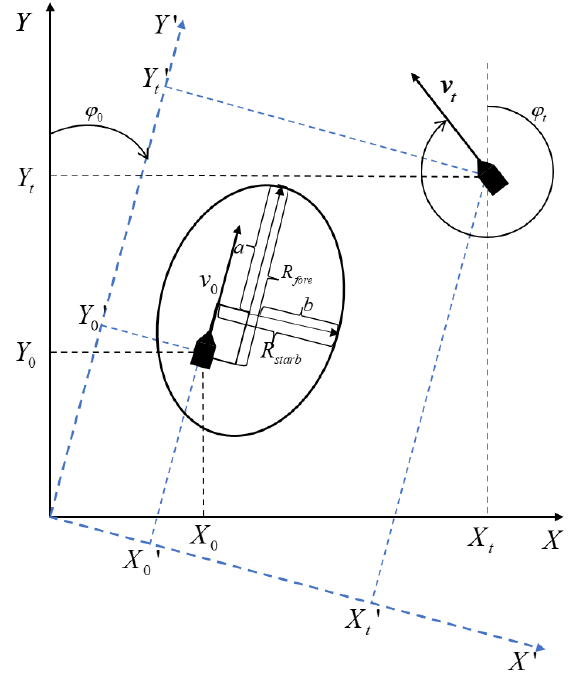
Figure 8. Schematic diagram of ship encounter parameters.